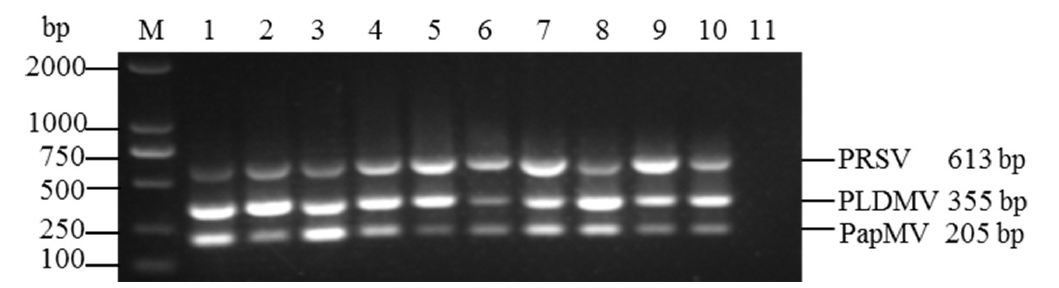
Figure 3. Optimization of the concentrations of three primer pairs used for the multiplex RT-PCR assay of PRSV, PLDMV, and PapMV. The amplified products of PRSV, PLDMV, and PapMV are indicated by the sizes of 613 bp, 355 bp, and 205 bp, respectively. Lanes 1–10 indicate the concentration combinations of three primers specific for PRSV, PLDMV, and PapMV: (1) 0.4:0.4:0.4 μM; (2) 0.4:0.4:0.2μM; (3) 0.4:0.2:0.4 μM; (4) 0.4:0.2:0.2 μM; (5) 0.4:0.2:0.1 μM; (6) 0.4:0.1:0.1 μM; (7) 0.4:0.1:0.2 μM; (8) 0.2:0.2:0.2 μM; (9) 0.2:0.1:0.1 μM; (10) 0.1:0.1:0.1 μM. Lane 11: negative control (ddH2O); Lane M: DL2000 DNA